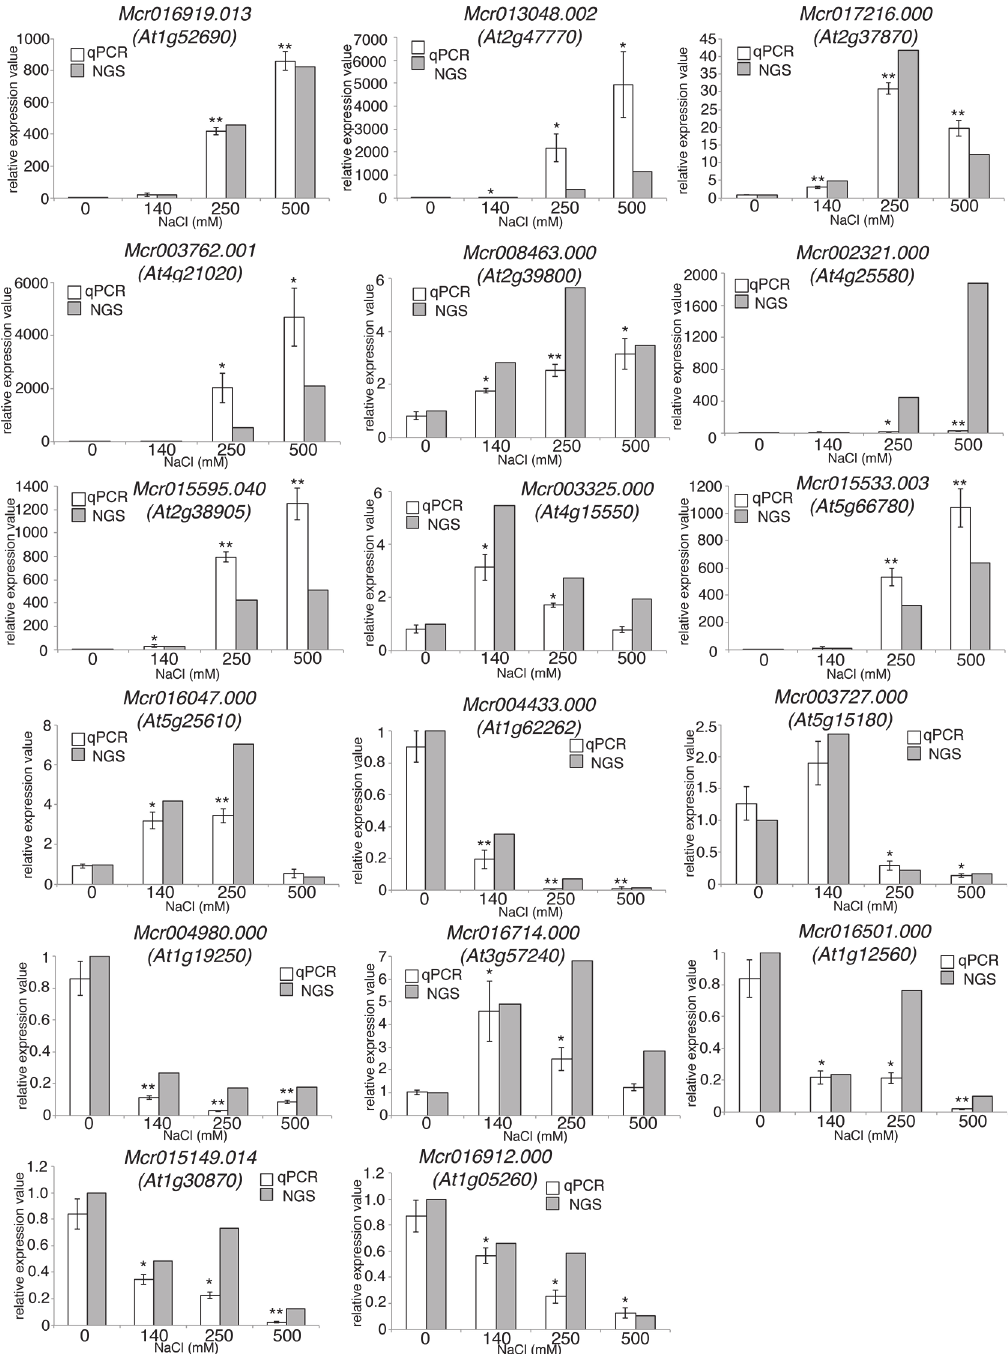
Fig 4. Comparison of gene expression data obtained by RNAseq and by RT-qPCR. Expression level of selected genes in whole roots of ice plant subjected to 0 mM, 140 mM, 250 mM, or 500 mM NaCl treatment for 24 h as measured by RT-qPCR (white boxes). Gene expression was normalized against the housekeeping gene, PolyUBQ10 . (n = 3, ± S.D.; ** and * indicate p < 0.001 and p < 0.05 by Student ’ s t -test, respectively, the comparison is between 0 mM NaCl and the remaining NaCl concentrations). Gray boxes (NGS) indicate the level of gene expression obtained from RNAseq data. The RNAseq data are shown as the level of expression relative to 0 mM NaCl treatment which was set at a value of 1.